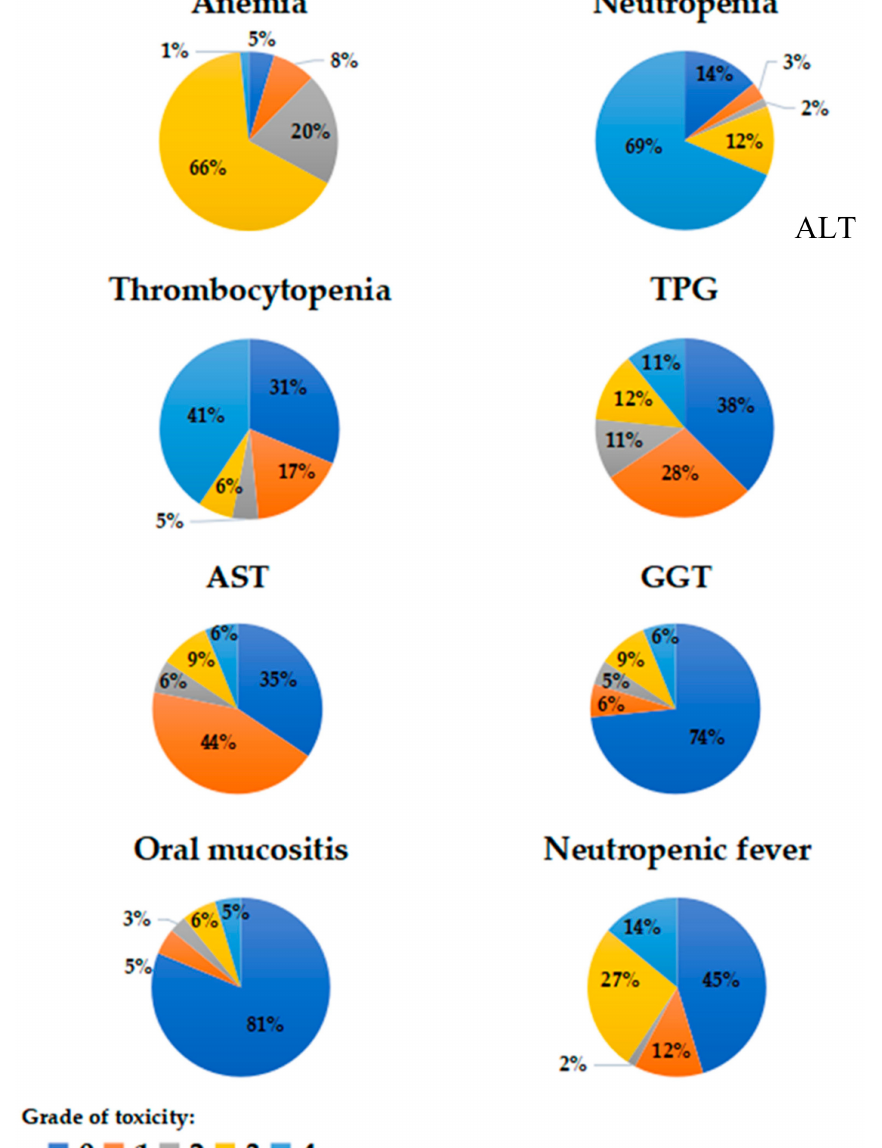
Figure 2. The most common toxicities observed in the study patients during the follow-up period, as well as their severity level according to the CTCAE 4.0 classification. The proportion of patients with anemia, neutropenia, thrombocytopenia, liver enzyme elevations, oral mucositis, and neutropenic fever is shown. The toxicity is graded in five categories according to the CTCAE 4.0 Classification, without any patient achieving grade 5 toxicity. CTAE: Common Terminology Criteria for Adverse Events. ALT: alanine aminotransferase; AST: aspartate aminotransferase; GGT: gamma-glutamyl